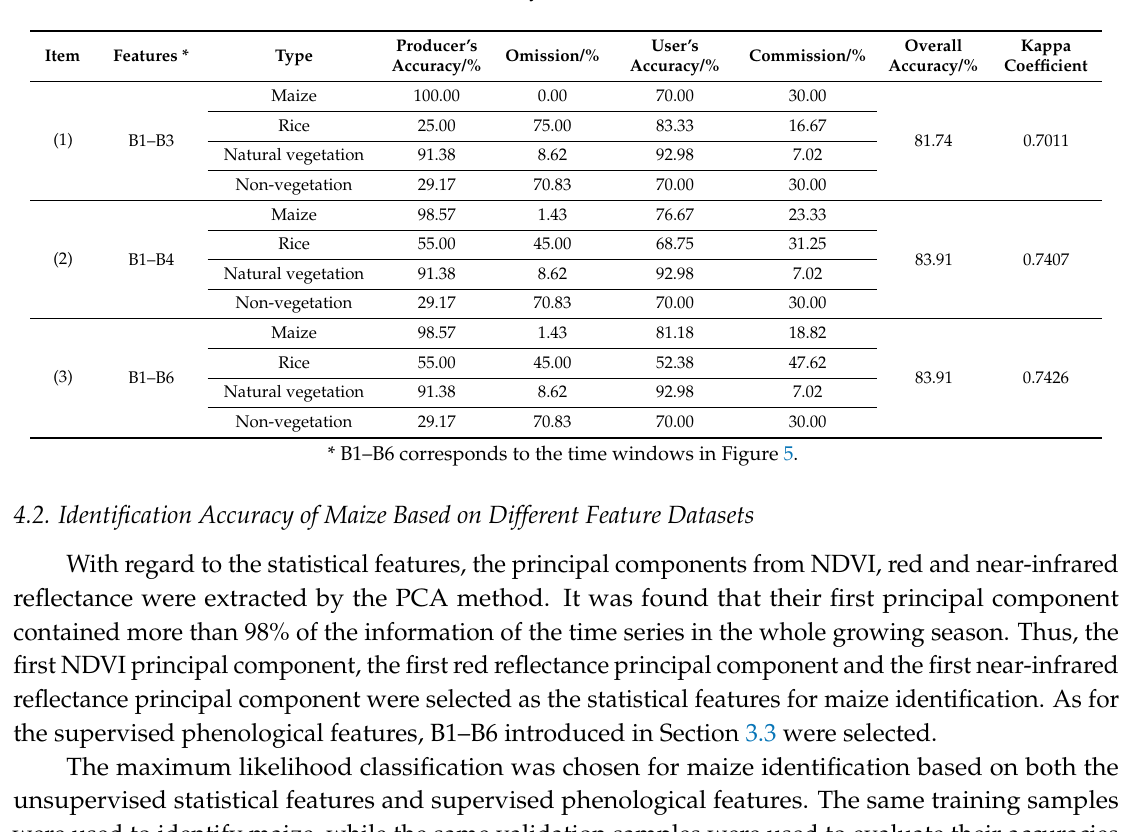
Table 3. Identification accuracy of maize based on different metrics.